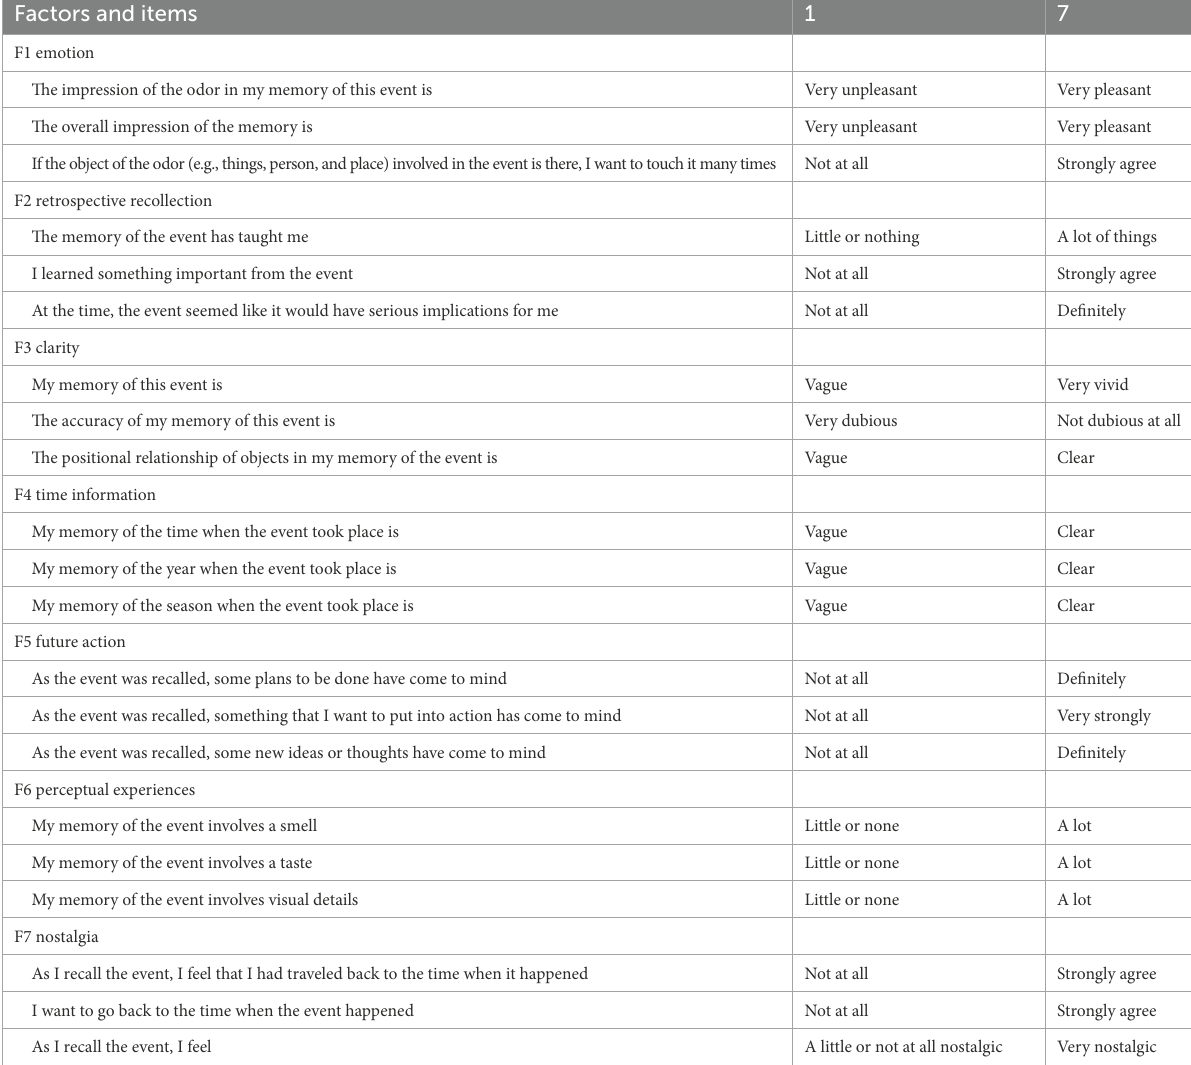
TABLE 1 Structure of the OEAMQ (odor-evoked autobiographical memory questionnaire) composite